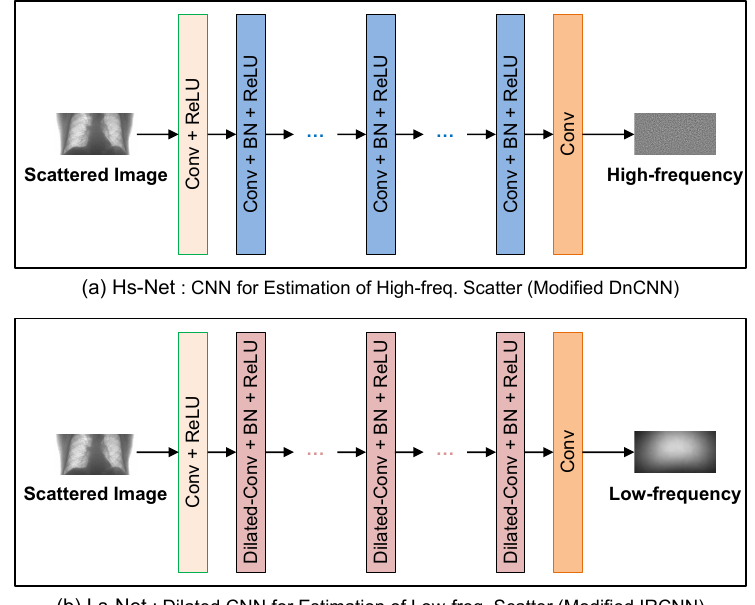
Figure 3. Hs-Net for high-frequency component of scatter ( a ); and Ls-Net for low-frequency component of scatter ( b